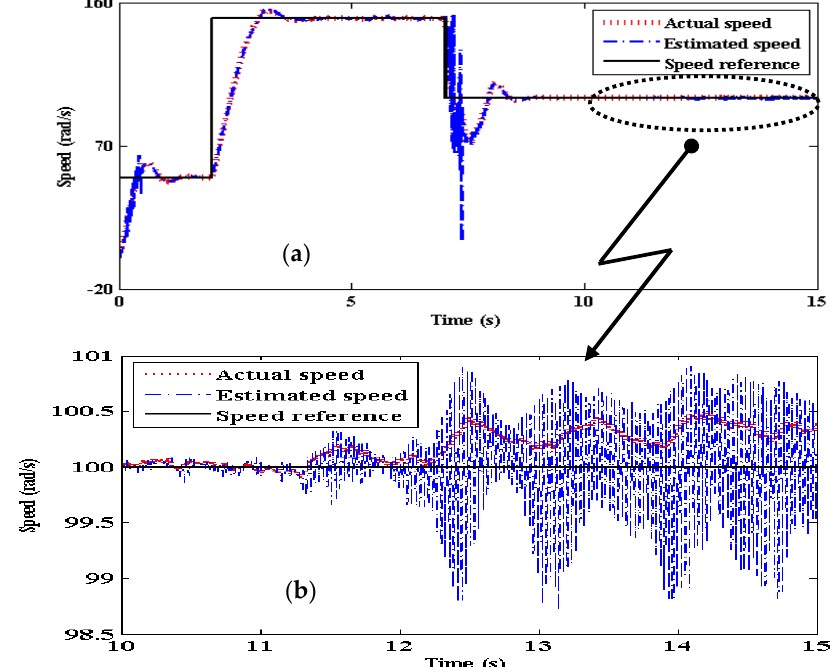
Figure 14. ( a ) Estimated speed of SMLO 1; and ( b ) zoomed version of ( a ).